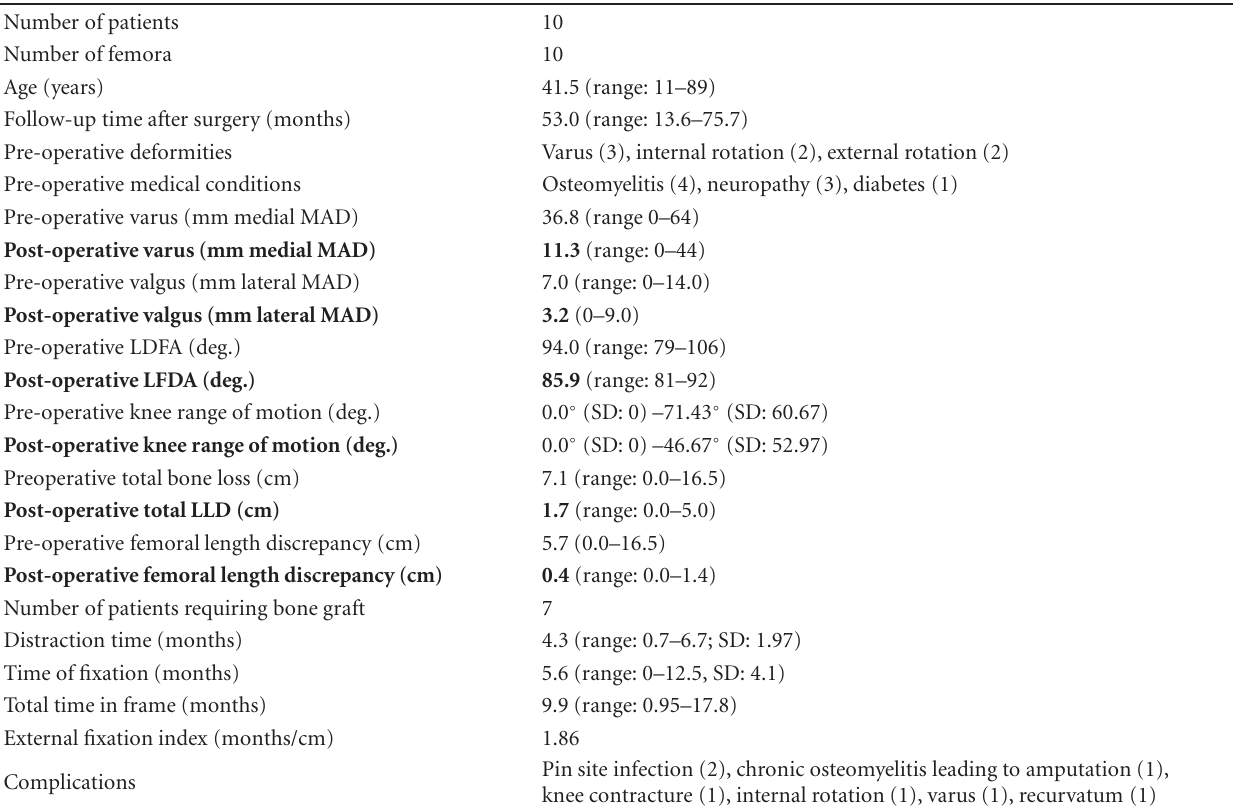
Table 4: Bone transport and nonunion